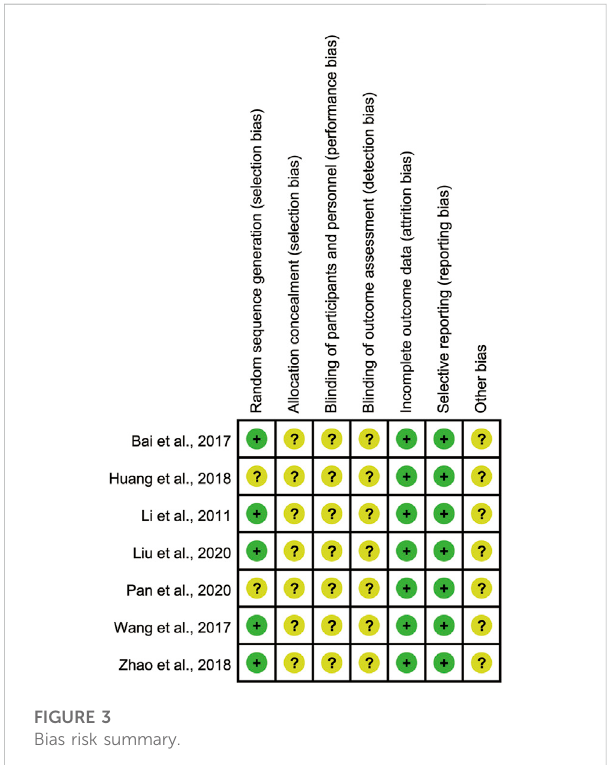
FIGURE 3 Bias risk